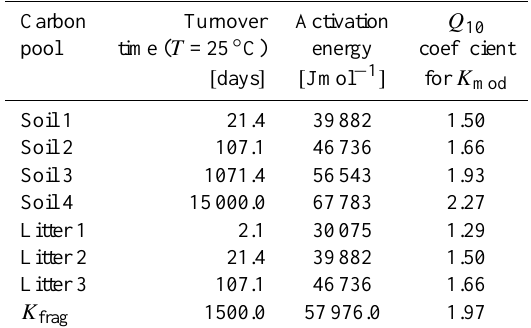
Table 1. Values for the parameters used in the calculation of the temperature sensitivity of decomposition rates for this study (Eq. 4). Turnover times for all carbon pools are from Thornton and Rosenbloom (2005) and are the same as those used in CLM4. Acti- vation energies are computed using the linear fit given by Knorr et al. (2005) in their Fig. 2. A least-squares, best-fit Q 10 coefficient is given for each of the modified decomposition rates, k mod ( T